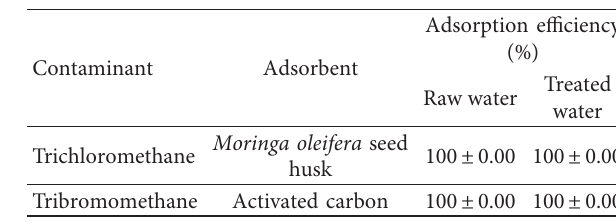
Table 4: Adsorption efficiency of Moringa oleifera seed husk ac- tivated carbon on raw and treated